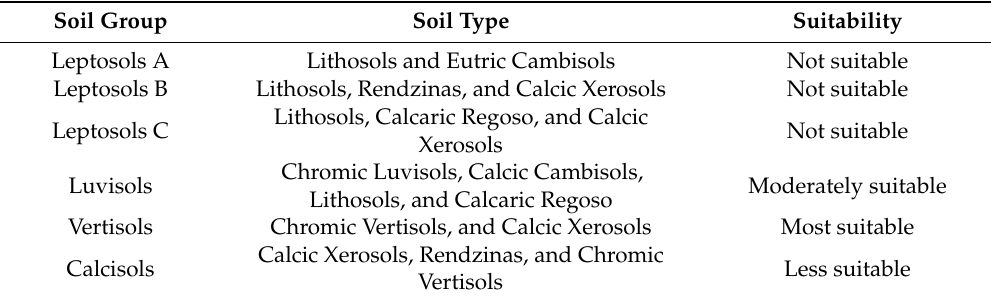
Table 4. Soil group types in the study area.